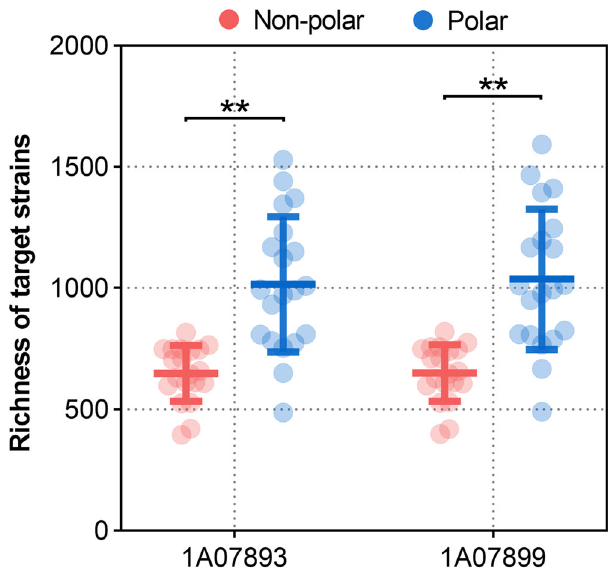
Fig. 2 Global distribution of L. salsilacus . Abundances of L. salsilacus 1A07893 and 1A07899 recovered from 40 global seawater metagenomes, including those from polar and non-polar regions, are shown. Differences between the average abundance of L. salsilacus in non-polar and polar regions were estimated by a two-tailed t -test, and signi fi cant differences were indicated by asterisks (** p <